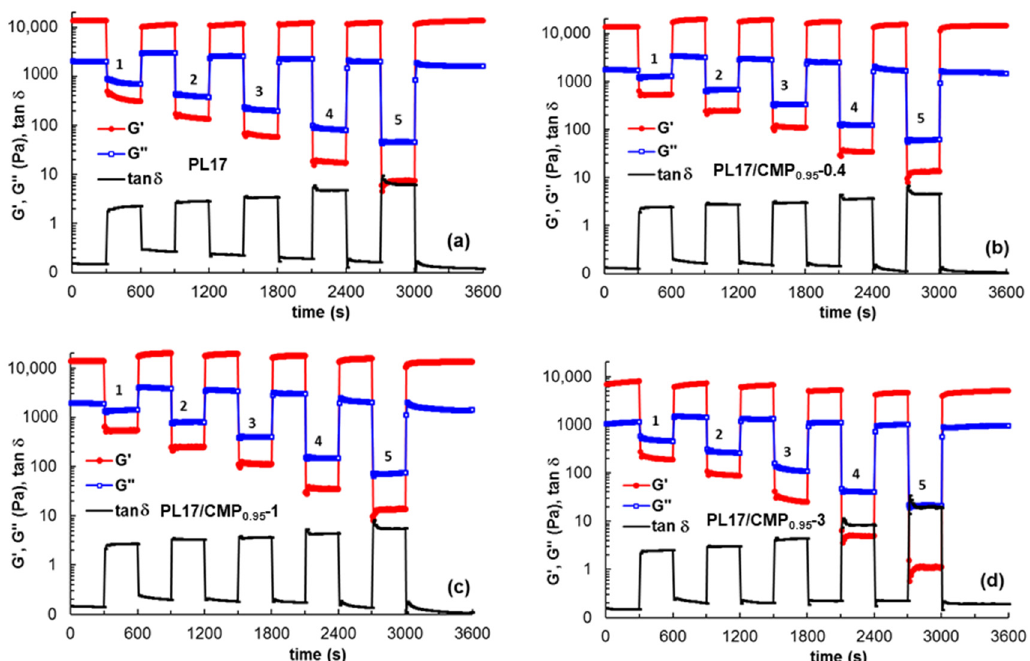
Figure 12. Self-healing behavior for samples PL17 ( a ), PL17/CMP 0.95 -0.4 ( b ), PL17/CMP 0.95 -1 ( c ) and PL17/CMP 0.95 -3 ( d ) by applying step strains cycles of small—high—small strain values. The small level of strain was always 1% and the high level of strain was increased successively: 1–50%; 2–100%; 3–200%; 4–500%; and 5–1000%.